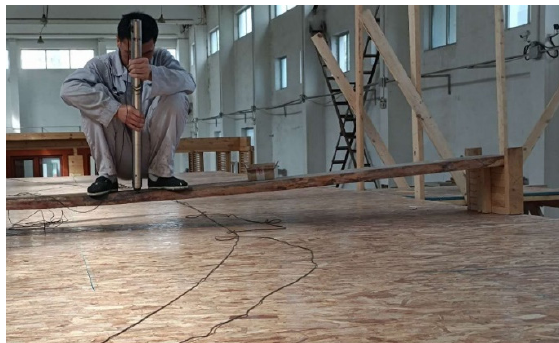
Figure 10. Distribution of the monitoring points (unit: mm).